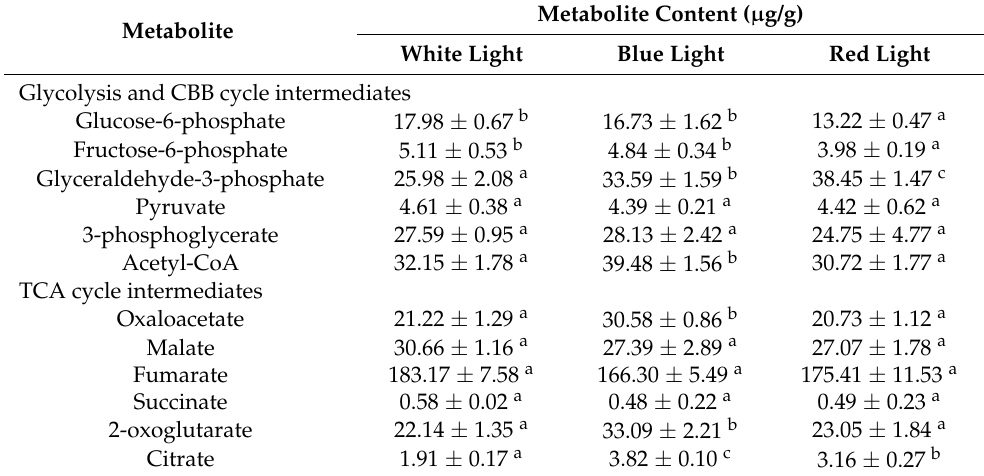
(Figure 6a and Table 1) may lead to an enhanced TCA cycle or lipid biosynthesis [10]. Among TCA cycle metabolites, the contents of oxaloacetate and 2-oxoglutarate, the pre- cursors of aspartate and glutamate, increased under blue light. Combining these pieces of evidence with the results of carbon partitioning and cell cycle (Figures 4 and 5) indicates that blue light could turn carbon skeletons from carbohydrates into proteins, which is essential for cell division. Table 1. LC-MS results for various metabolites of C. reinhardtii at different light wavelengths at 12 h of N-recovery. Data in the table are presented in the form of means ( n = 3) ± the standard deviation. The same letter (a, b, c) on each bar indicates that the difference is not significant ( p > 0.05), and different letters indicate a significant difference ( p < 0.05). Metabolite Content ( µ g/g) Metabolite White Light Blue Light Red Light Glycolysis and CBB cycle intermediates Glucose-6-phosphate 17.98 ± 0.67